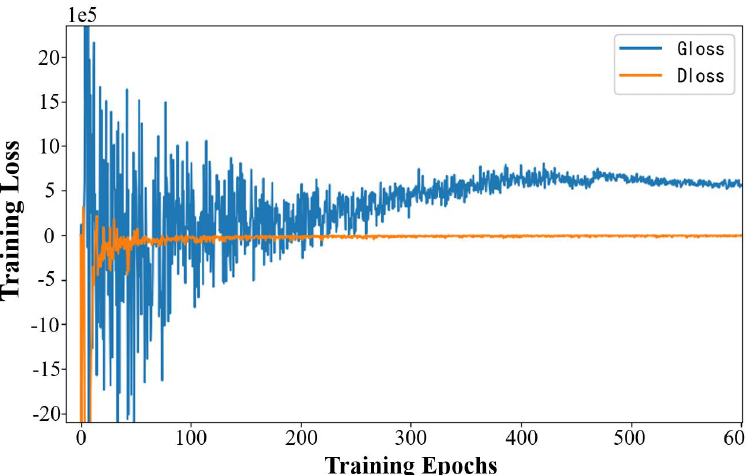
Figure 8. The convergence curves of the generator and the discriminator in the training process. The curve of the generator’s training loss is depicted by the blue solid line. The curve of the discriminator’s training loss is depicted by the orange solid